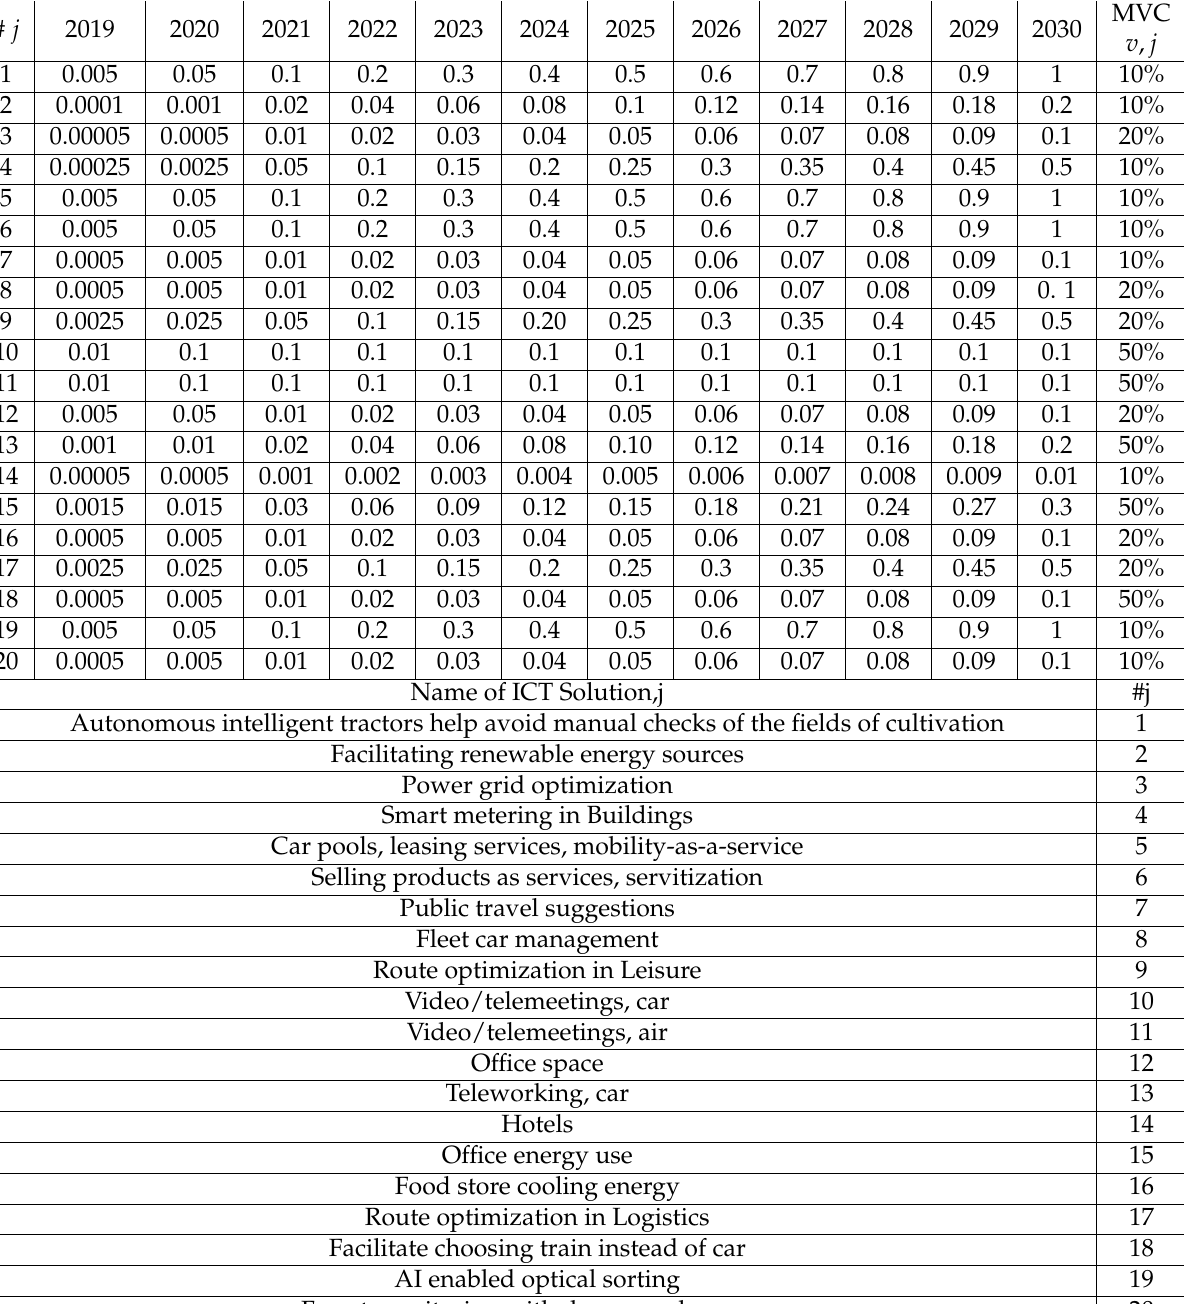
Table 4. Evolution matrix for F and MVCV for t = 2019 to 2030 for chosen i and j